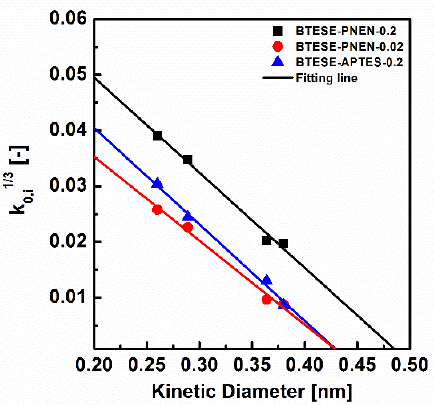
Figure 8. Relationship between kinetic diameters and k 0,i for BTESE-PNEN-0.2, 0.02 and BTESE- APTES-0.2 membranes (symbols: experimental; solid curves: calculated based on Equation (4)). Table 5. Pore size and apparent activation energy based on modified GT model. Fitting Plot Membrane